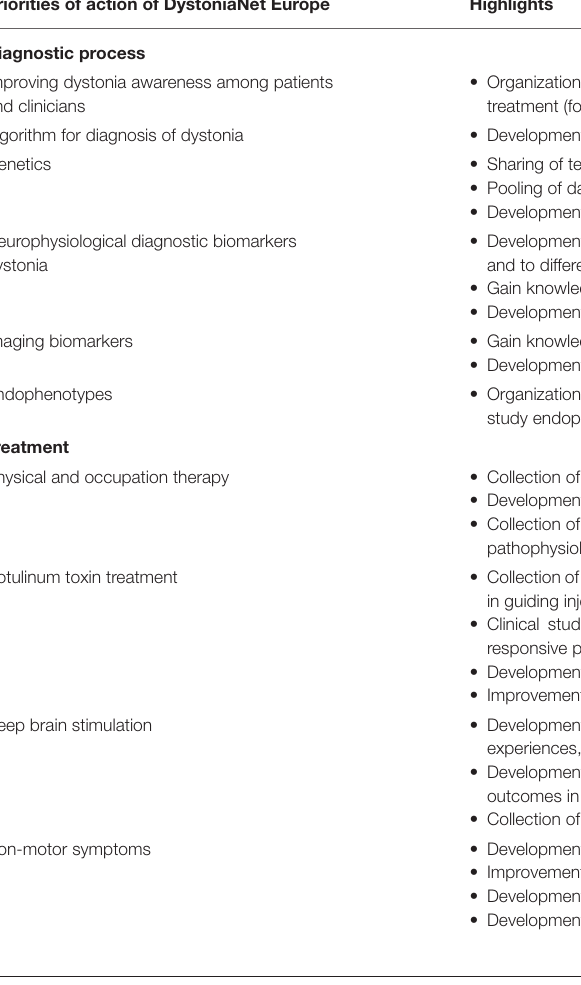
TABLE 1 | Goals DystoniaNet Europe. Priorities of action of DystoniaNet Europe